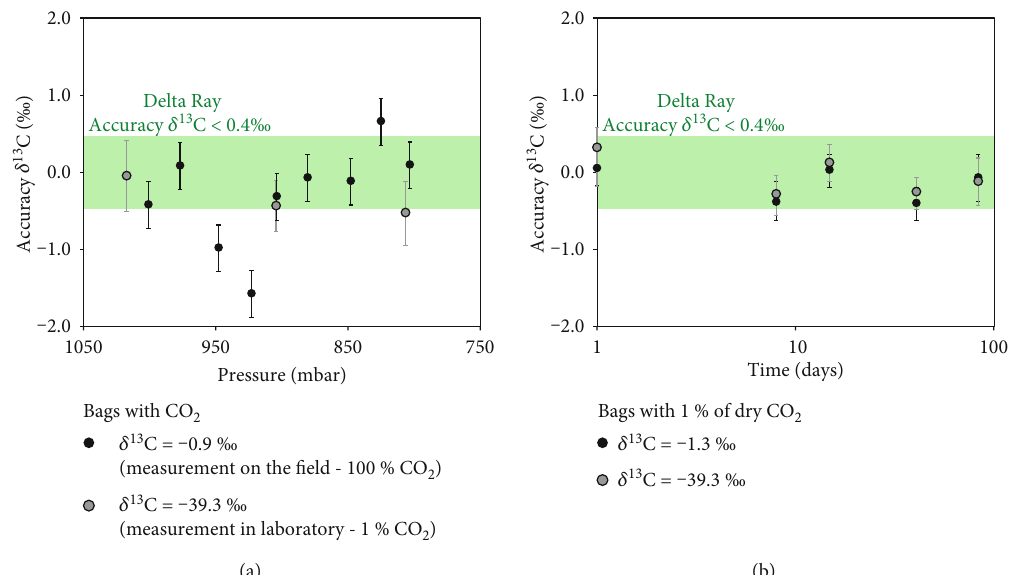
Figure 6: Dependence of δ 13 C measurements on environmental conditions. (a) Accuracy of δ 13 C measurements of CO pressure of (i) analysis (in black; each 25mbar) or of (ii) gas sampling (in gray). (b) Accuracy of δ 13 C measurements of CO the time of gas storage in Multi-Layer Foil gas sampling bags (Restek). Green fi elds show the fi elds of accuracy of δ 13 C measurements determined in this study (DR1 and